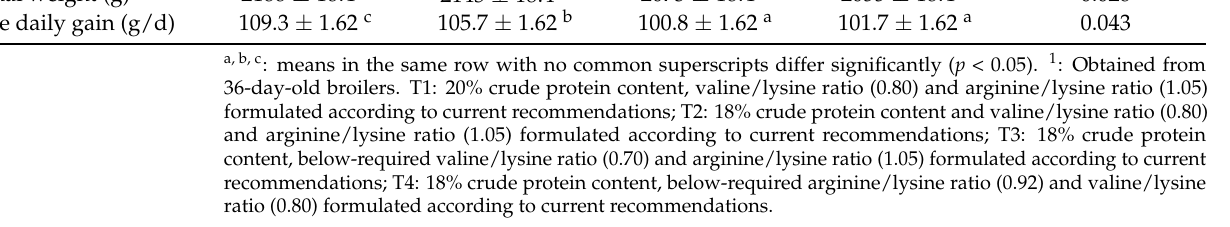
Table 2. Average serum uric nitrogen (SUN) and productive traits ( ± standard error of the mean) obtained in each experimental diet (T1 to T4) during the grower phase (from 14 to 35 days of age). T1 T2 T3 T4 p -Value SUN (mg/dL) 1 1.96 ± 0.1 a 1.89 ± 0.1 a 1.90 ± 0.1 a 2.26 ± 0.1 b 0.001 Final weight (g) 2188 ± 18.4 c 2143 ± 18.4 b 2073 ± 18.4 a 2055 ± 18.4 a 0.028 Average daily gain (g/d) 109.3 ± 1.62 c 105.7 ± 1.62 b 100.8 ± 1.62 a 101.7 ± 1.62 a